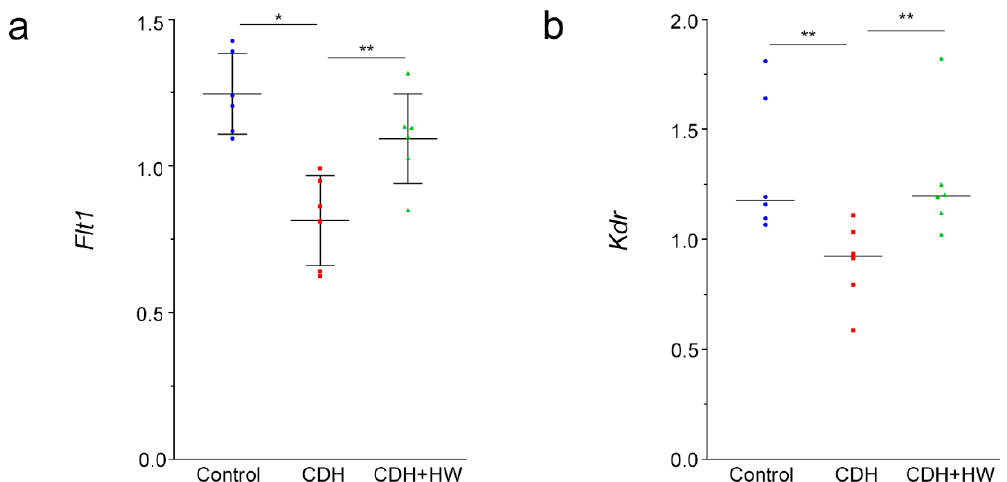
Figure 4. Vascular endothelial growth factor receptors (VEGFRs) mRNA expression. ( a ) Flt1 (Fms related receptor tyrosine kinase 1, Vegfr-1 ) and ( b ) Kdr (kinase insert domain receptor, Vegfr-2 ) mRNA expression in the lungs derived from pups in the control, CDH, and CDH + hydrogen-rich water (HW) groups (each group, n = 6). The bars indicate the mean ± standard deviation (SD) ( a ) and the median ( b ) for normal and non-normal distributions, respectively. * p < 0.01, ** p < 0.05.